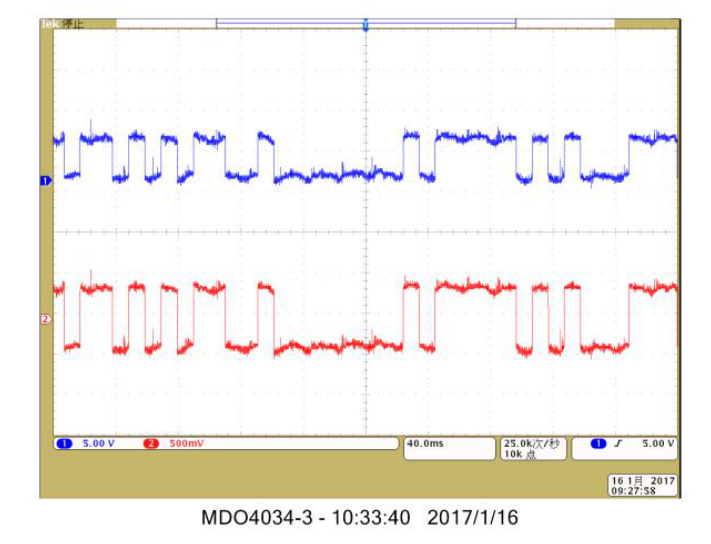
Figure 11. Pseudo random sequence signals measured by MDO4034.